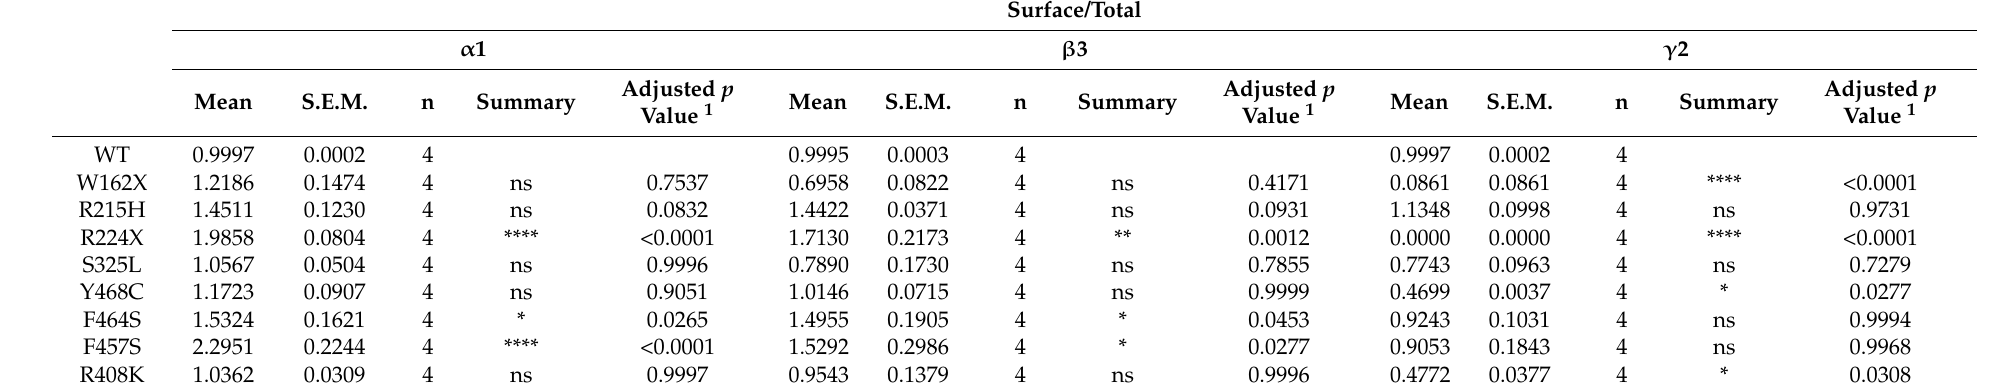
Table 6. Effects of GABRG2 variants on α 1 β 3 γ 2 receptor surface